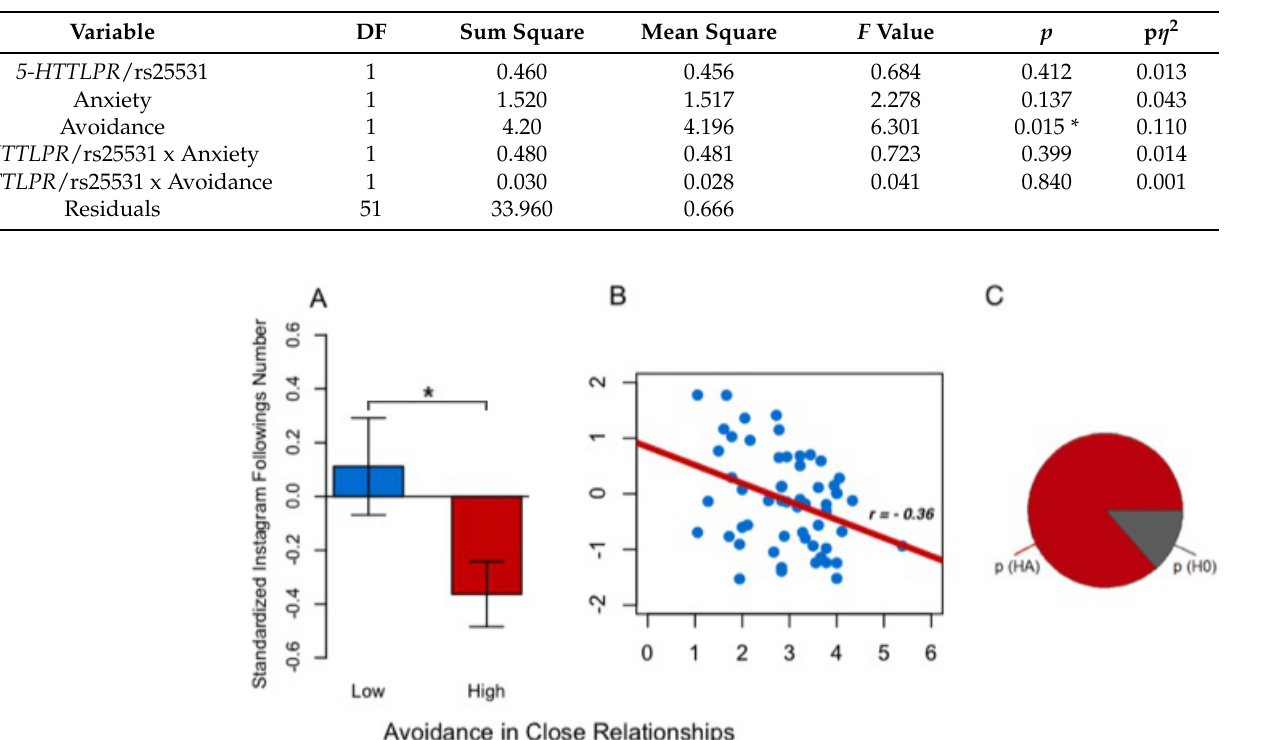
Figure 1. Effect of the avoidance on the standardized Instagram number of followings. ( A ) Contrast between low (blue) and high (red) scores pf ECR-R avoidance on Instagram number of followings. ( B ) Linear model with ECR-R Avoidance as continuous predictor of Instagram number of followings as continuous dependent variable. ( C ) Positive evidence for the alternative model HA (pBIC = 0.864; red area) and weak evidence for the null model H0 (pBIC = 0.135; grey area). (* p <